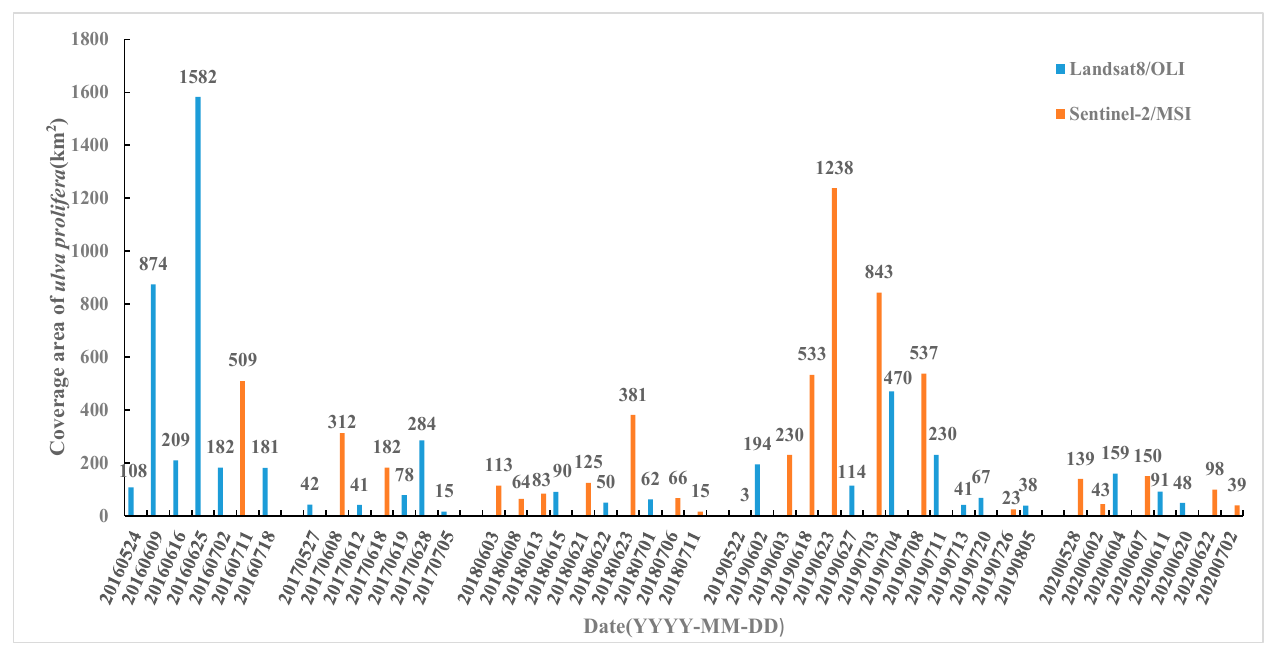
Figure 10. Statistical chart of U. prolifera area based on Landsat8/OLI and Sentinel-2/MSI satellites in the study area from 2016 to